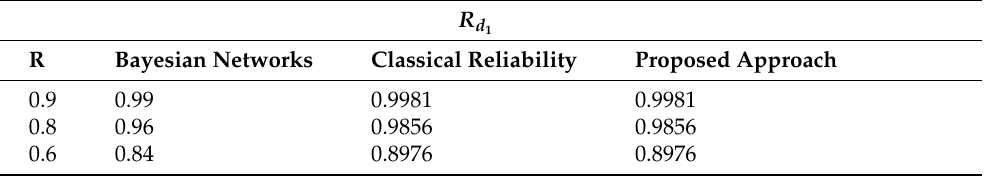
Table 1. Results